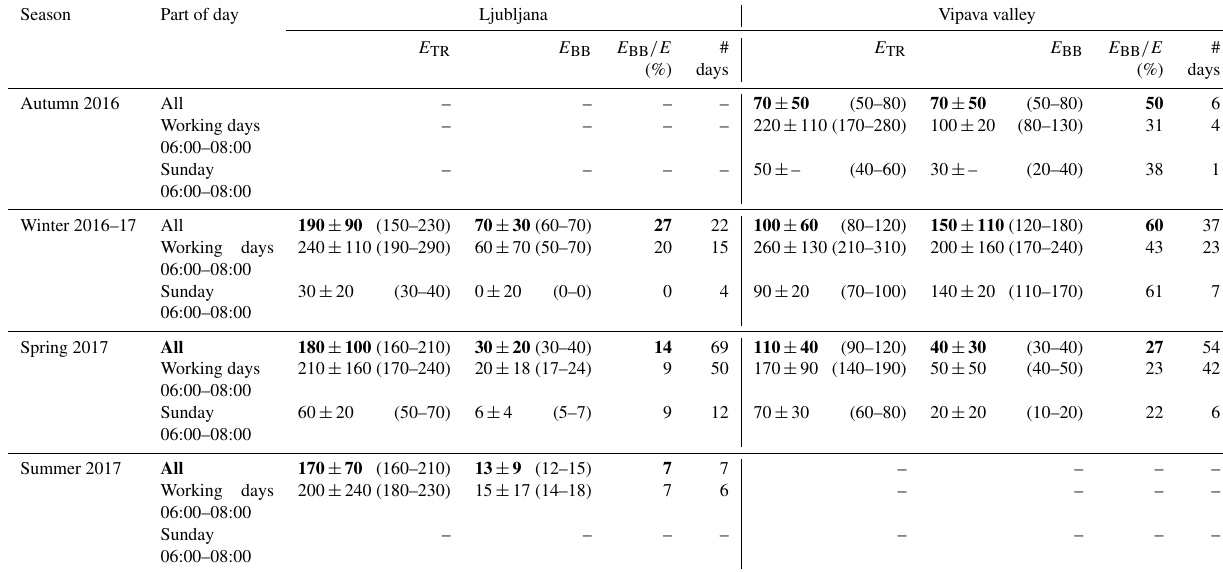
Table 5. BC emission rates ( E BC ) (weighted mean ± standard deviation derived from daily mean values) and range of E BC for lower and upper MLH Rn estimates ( E BC − min – E BC − max ). TR (traffic) and BB (biomass burning) emissions are reported separately for each season (all days, mornings of working days and Sundays) and location, expressed in micrograms per square metre per hour. Daily mean values for specific seasons are marked with bold font.